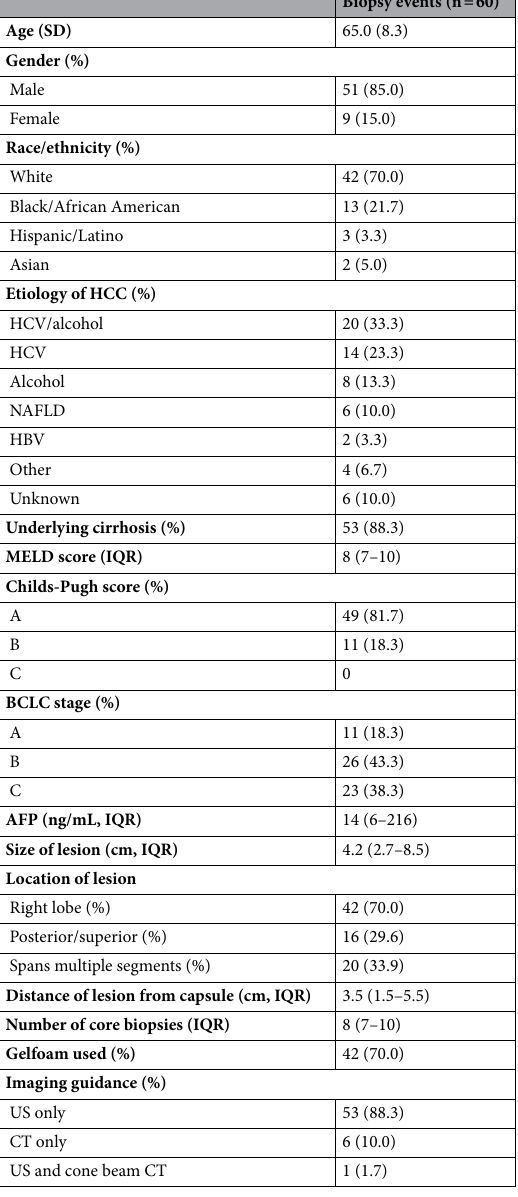
Table 1. Patient and biopsy